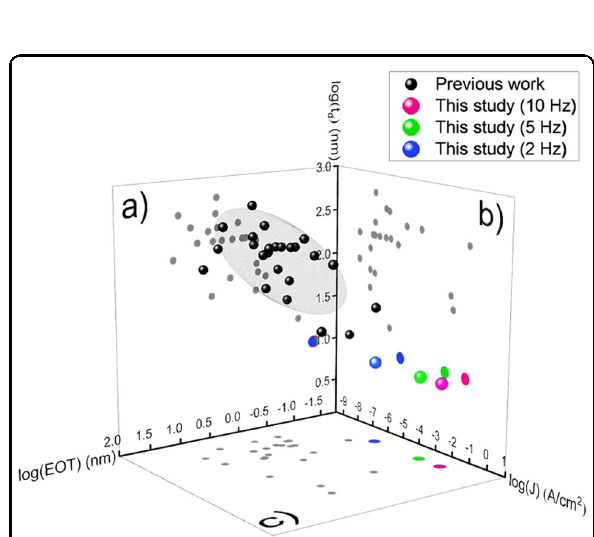
Fig. 5 3D plots comparing the performance of capacitors that were previously developed and those reported herein. a Equivalent oxide thickness versus thickness of the dielectric layer, b leakage current density versus thickness of the dielectric layer, and c equivalent oxide thickness versus leakage current